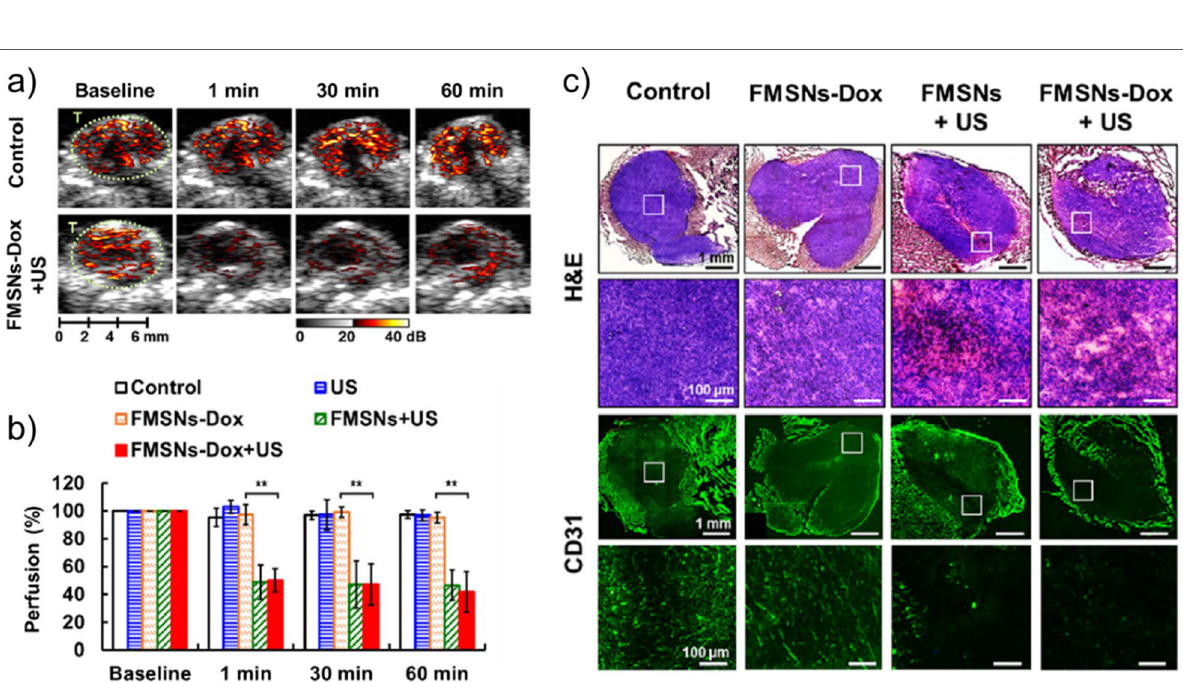
Fig. 9 In vivo tumor ablation using GSNs. a Ultrasound images showing tumor perfusion of intravenously injected microbubbles showing anti-vascular effect of HIFU treatment in the presence of GSNs. b Quantification of tumor perfusion in mice treated with different conditions. c Histological analysis of tumors untreated or treated using different conditions. H&E staining shows the necrosis induced by GSNs and ultrasound. CD31 staining was used to visualize tumor vasculature. Adapted from reference [40], Copyright 2020,